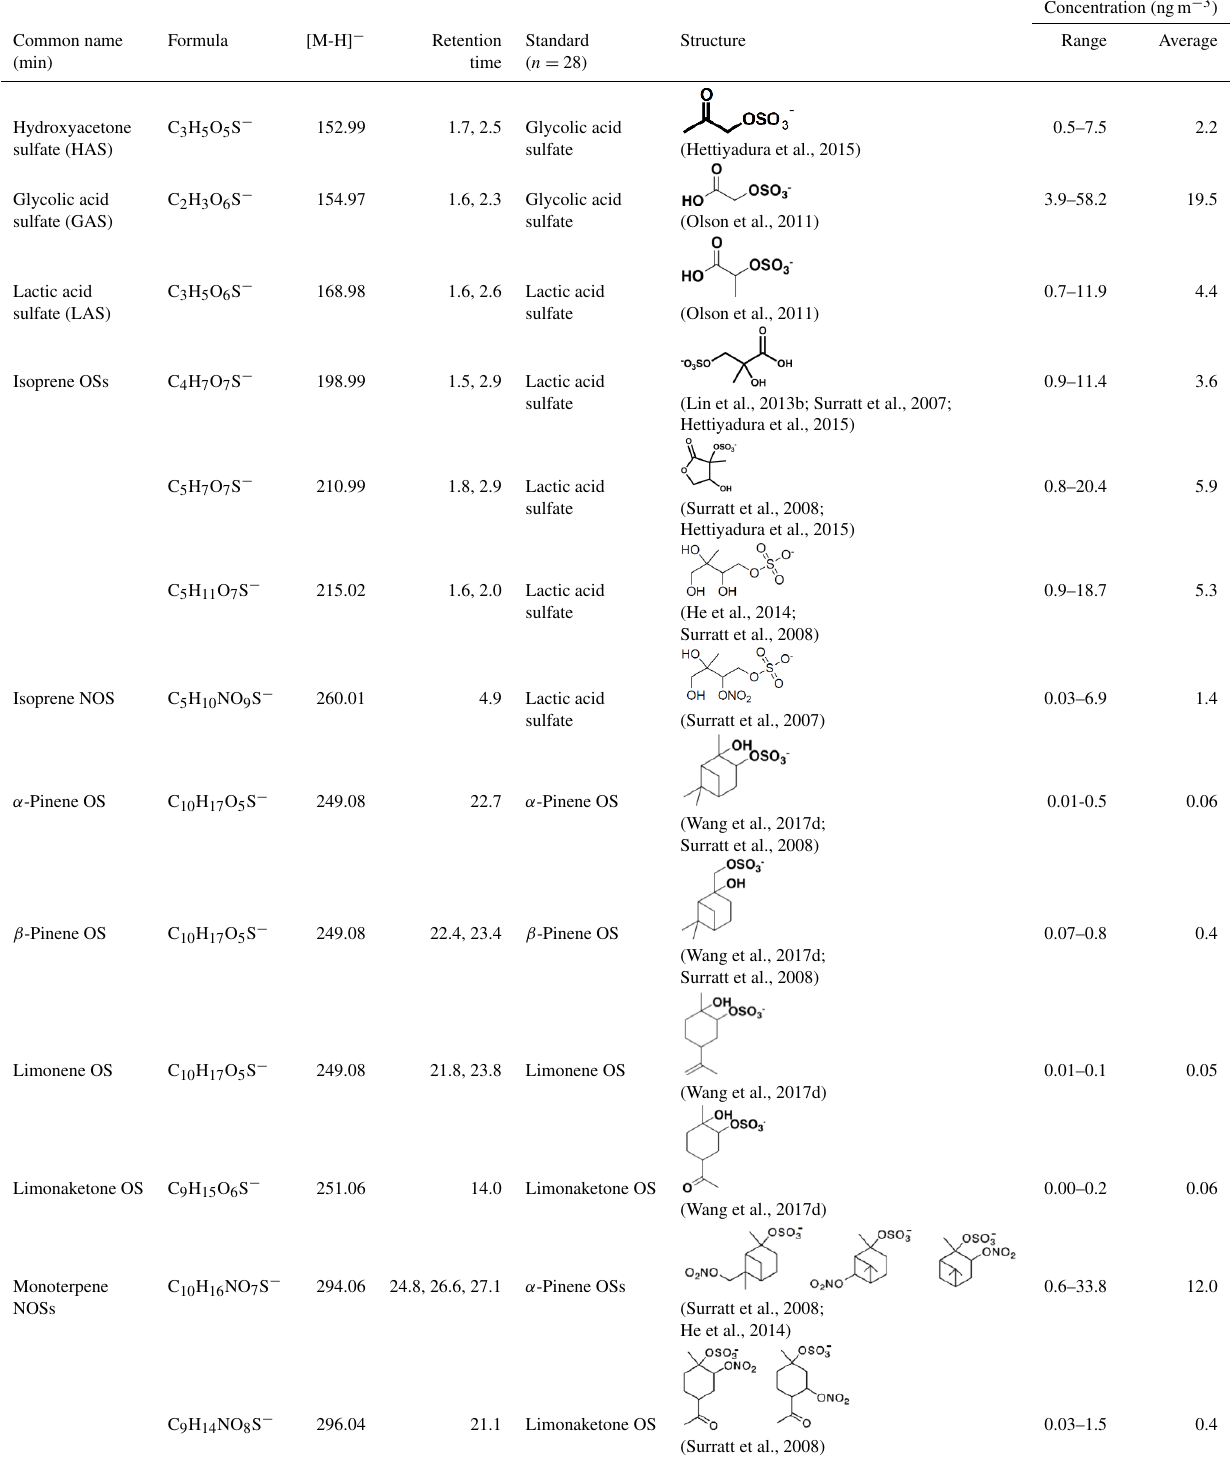
Concentration (ngm − 3